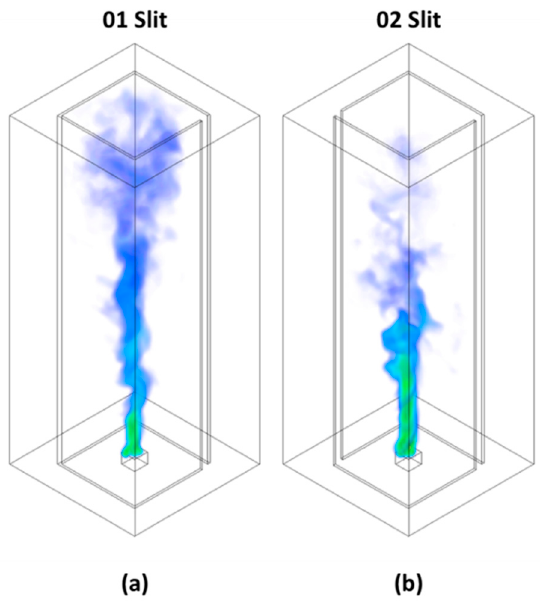
Figure 4. Temperature iso-surface of the fire whirl formulated in 01 slit case ( a ) and the 02 slit case ( b ).